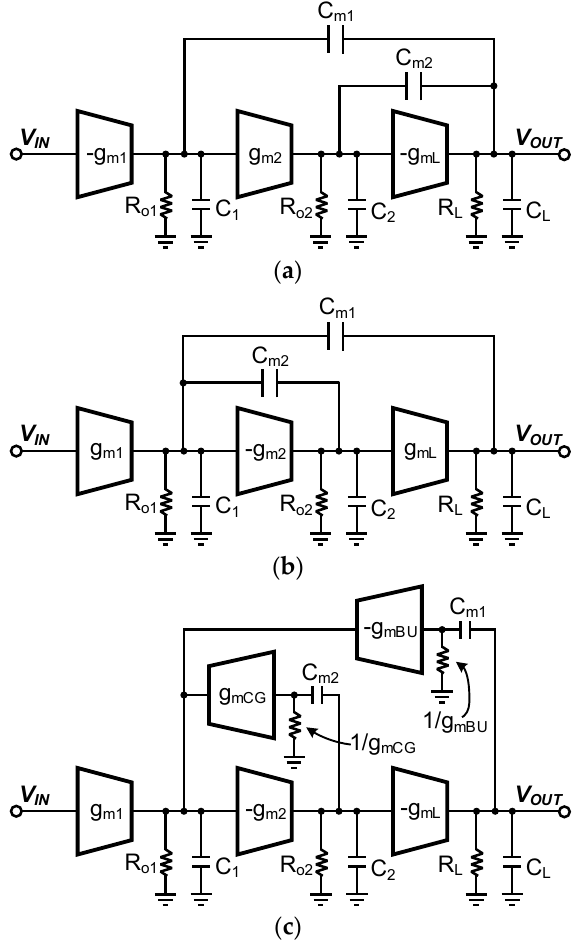
Figure 3. Block diagram of conventional frequency compensation methods. ( a ) NMC [17–19]; ( b ) reverse NMC [20,21]; and ( c ) reverse NMC with current buffers [22].